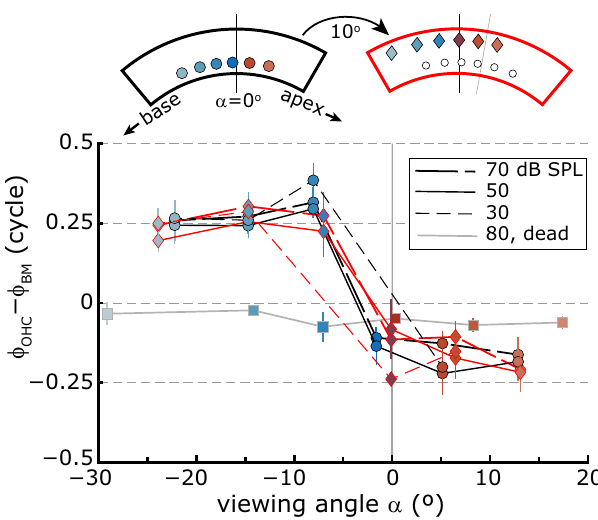
Fig. 4 Viewing angle, not longitudinal location, determines ϕ OHC – ϕ BM . OHC – BM phase difference, averaged across frequency, as a function of viewing angle α relative to the longitudinal axis of the BM (see Fig. 1b) for two series of recordings from the same animal, obtained at three different stimulus intensities (see legend). Vertical error bars give ±1 s.d. around the mean. After the acquisition of the fi rst series (black lines, circles), the animal was rotated 10° around the modiolar axis such that a more basal region of the cochlea was visualized and a second series of recordings was obtained (red lines, diamonds). The cartoon at the top represents this rotation, with the viewing angles at the recording locations color coded according to the key in Fig. 1. Square symbols/gray lines are for data acquired postmortem in the same